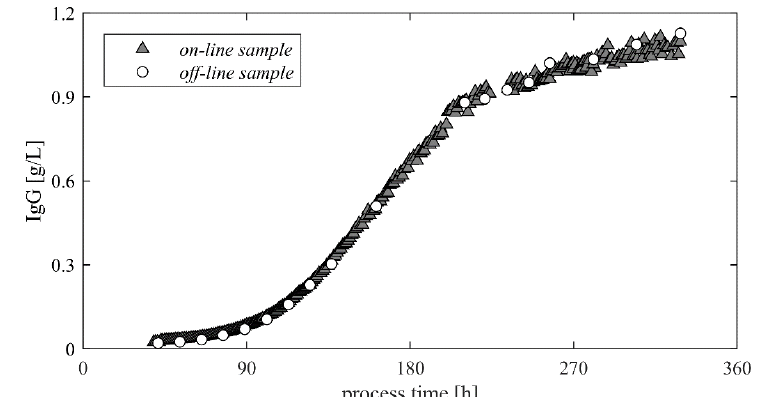
Figure A1. Concentration of product (IgG) in a CHO fed-batch over process time. The grey triangles represent measurements that were performed by the automated sampling and liquid handling system and an on-line HPLC. This data was available in real-time in process management software. The white circles display the corresponding results of the manual samples. Calibration of the HPLC was performed via the Numera system, as described in Section 3.1.